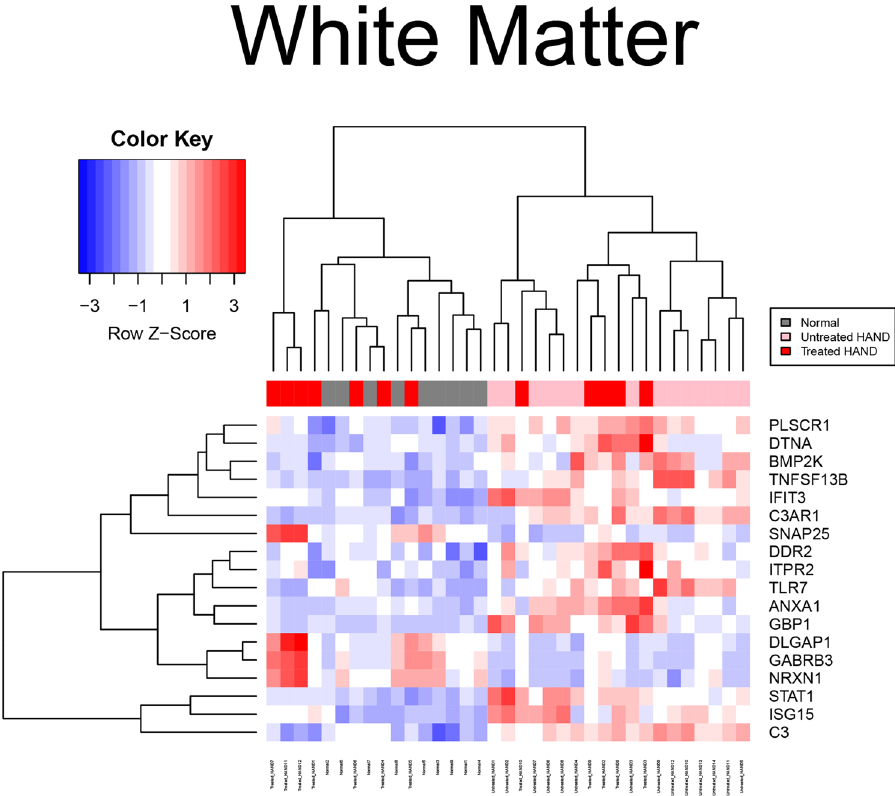
Figure 2. Heatmap of mRNA expression in the white matter of HAND patients. This figure represents the expression value of mRNA from the white matter of untreated HAND and control patients’ brains in GSE28160. The data were normalized using the GCRMA Bioconductor package. The mRNA expression of PLSCR1, DTNA, BMP2K, IFIT3, DDR2, ITRP2, TLR7, ANXA1, GBP1, SNAP25, NRXN1, DLGAP1, GABRB3, STAT1, ISG15, C3AR1, and C3 was chosen by comparing independent SAM results and identifying common markers that were shared between pathologies. The color key represents the Z score, the blue represents underexpression and the red represents overexpression. The larger sample size makes it easier to see trends compared to the other HAND dataset. We can observe overexpression of mRNA transcripts from untreated HAND including PLSCR1, DTNA, BMP2K, IFIT3, DDR2, ITRP2, TLR7, ANXA1, GBP1, STAT1, ISG15, C3AR1, and C3 . The mRNA expression of SNAP25 , NRXN1 , DLGAP1 , and GABRB3 was under-expressed compared to